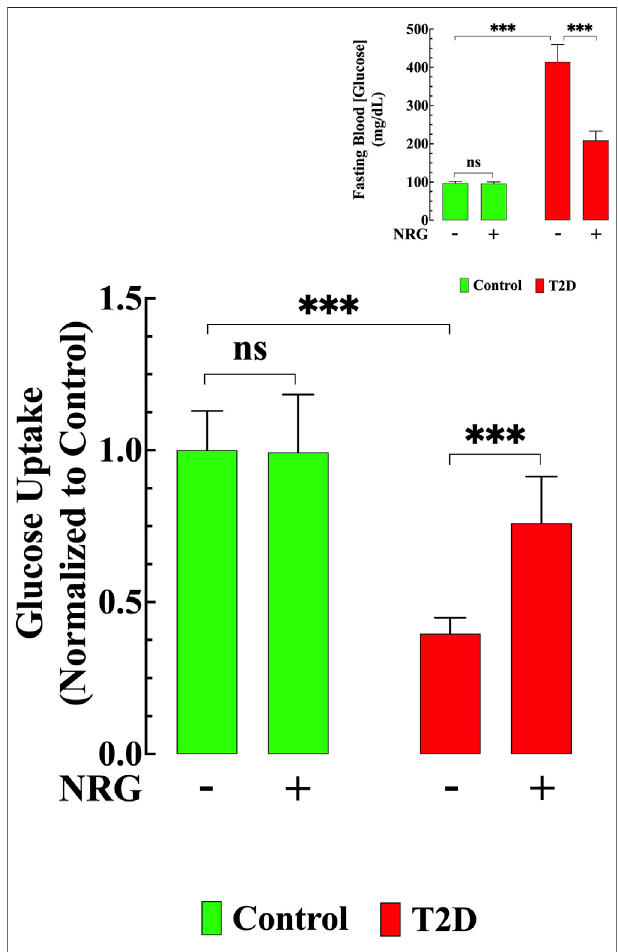
FIGURE 2 | Naringin improved glucose transport and lowered hyperglycemia.BasalglucoseuptakeinT2Dcardiomyocyteswassigni fi cantly reduced compared to control ( p < 0.001). Naringin treatment provoked a signi fi cant increase in glucose uptake in T2D cardiomyocytes compared to untreated T2D cardiomyocytes ( p < 0.001). Naringin treatment did not modify cardiomyocytes ’ glucose uptake in control cardiomyocytes ( p (cid:1) 0.99). Glucose uptake experiments were conducted in n mice (cid:1) 5 / group; n cells (cid:1) 19 – 21/group. Insert shows the signi fi cant hypoglycemic effect of naringin in T2D mice ( p < 0.001), however, no effect was observed in naringin-treated control mice ( p (cid:1) 0.36 compared to untreated mice). Blood Glucose was measured in n mice (cid:1) 20/group; n determinations (cid:1) 15 – 20/group before and after naringin treatment. Values were normalized to control untreated cardiomyocytes (glucose uptake) or indicated as mg/dL (blood glucose) and expressed as means ± S.D. Statistical analysis was performed as described before, ns p > 0.05, *** p <